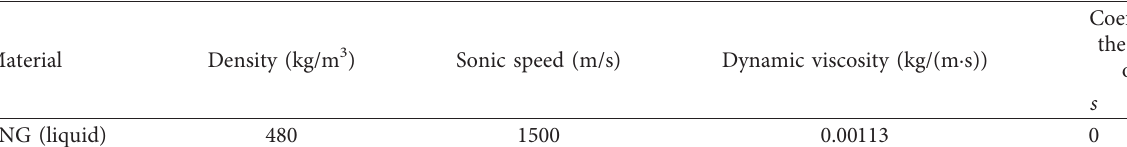
Table 5: Material properties of LNG.